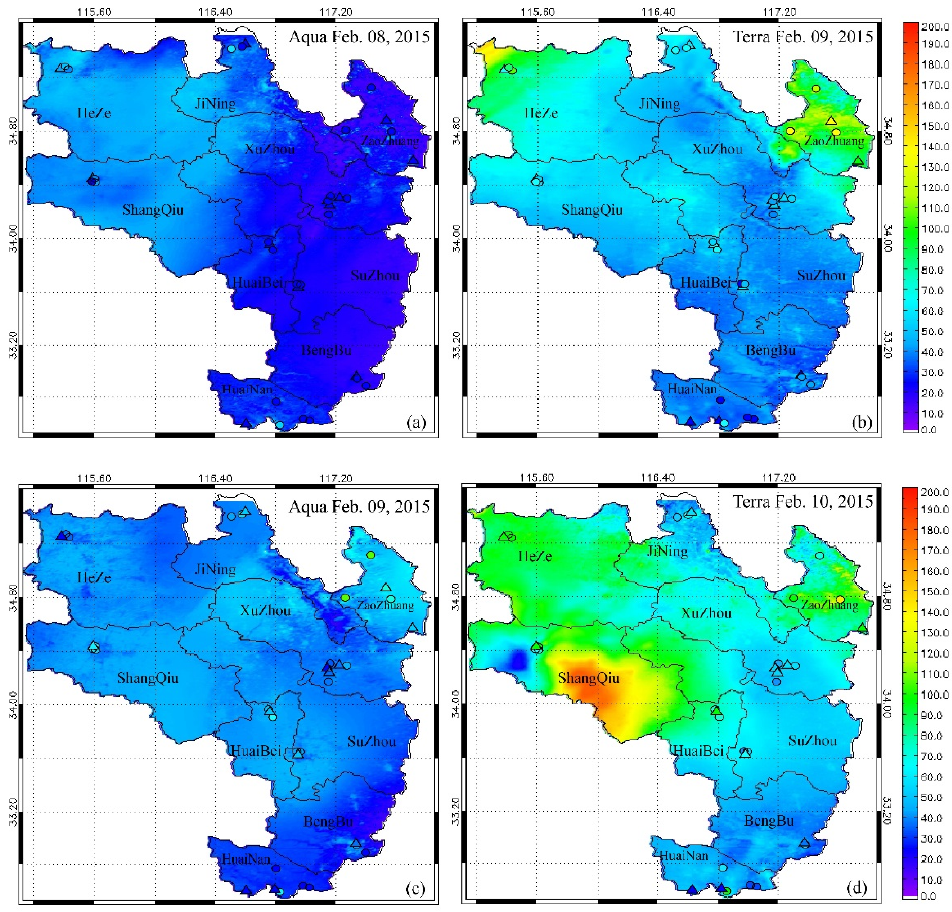
Figure 10. Cont. Figure 10.